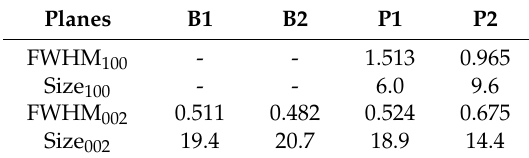
Table 4. FWHM ( ∆ ◦ 2 θ ) and domain size (nm) of HAP in the bones of Cololabis saira . Planes B1 B2 P1 P2 FWHM 100 - - 1.513 Size 100